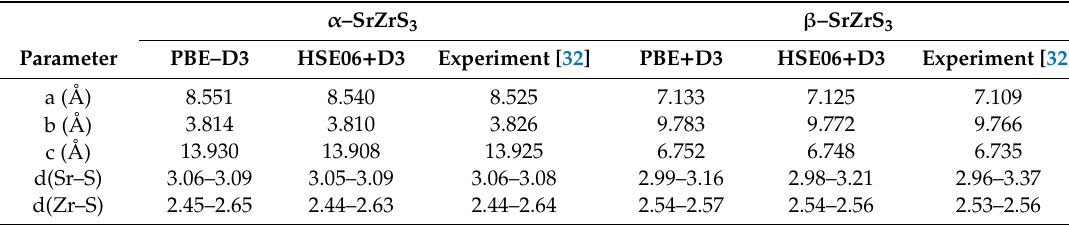
Table 1. Lattice constant (Å) and bond lengths (Å) of for α –SrZrS 3 and β –SrZrS 3 .